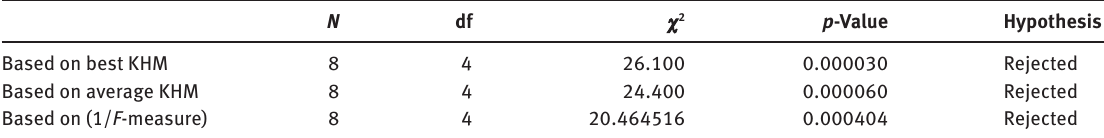
Table 7: Test Statistics in the Friedman Test. N df χ 2 p -Value